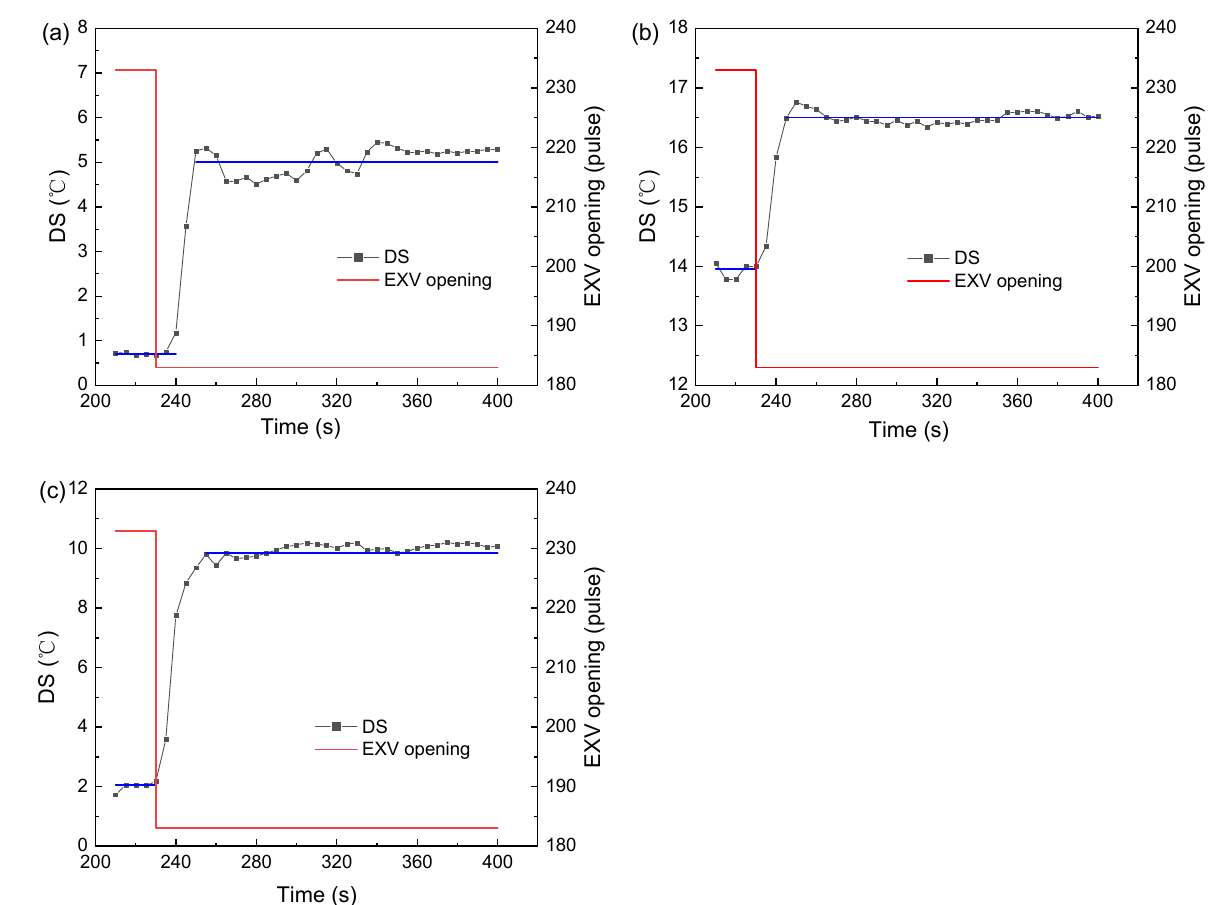
Figure 7. Response curves ( a ) refrigerant pump opening is 40%, frequency is 20 Hz; ( b ) refrigerant